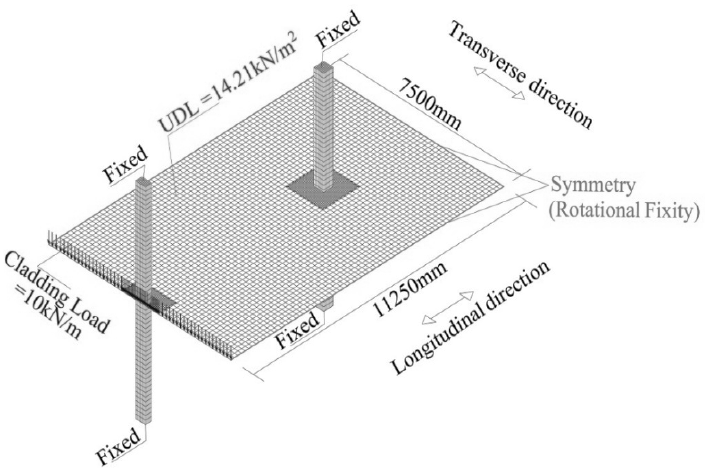
Figure 8. Subassembly of the designed flat